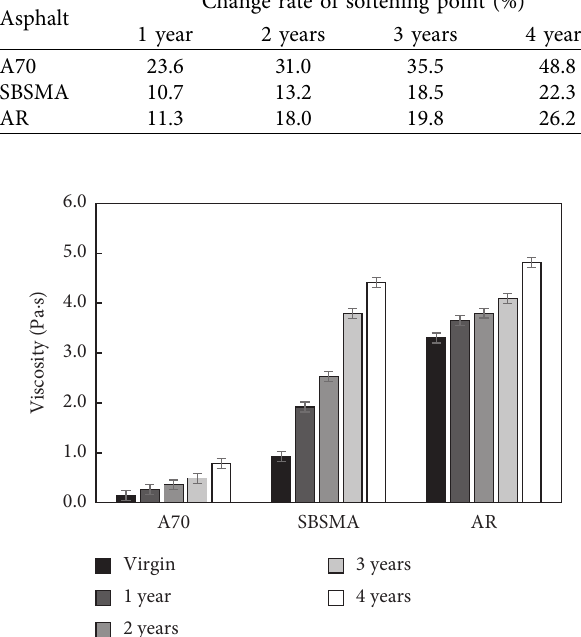
Figure 5: Viscosity of asphalt with different weathering time.